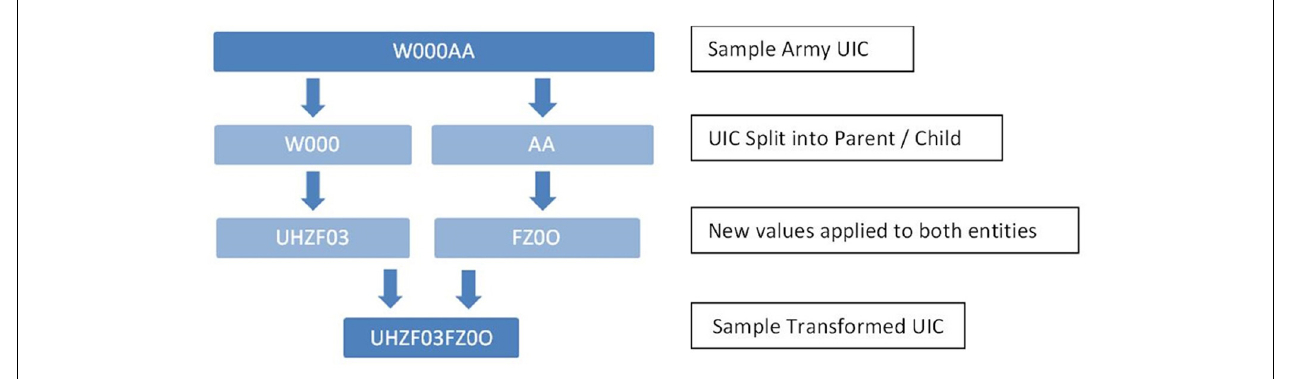
FIGURE 2 | Unit identification code (UIC)